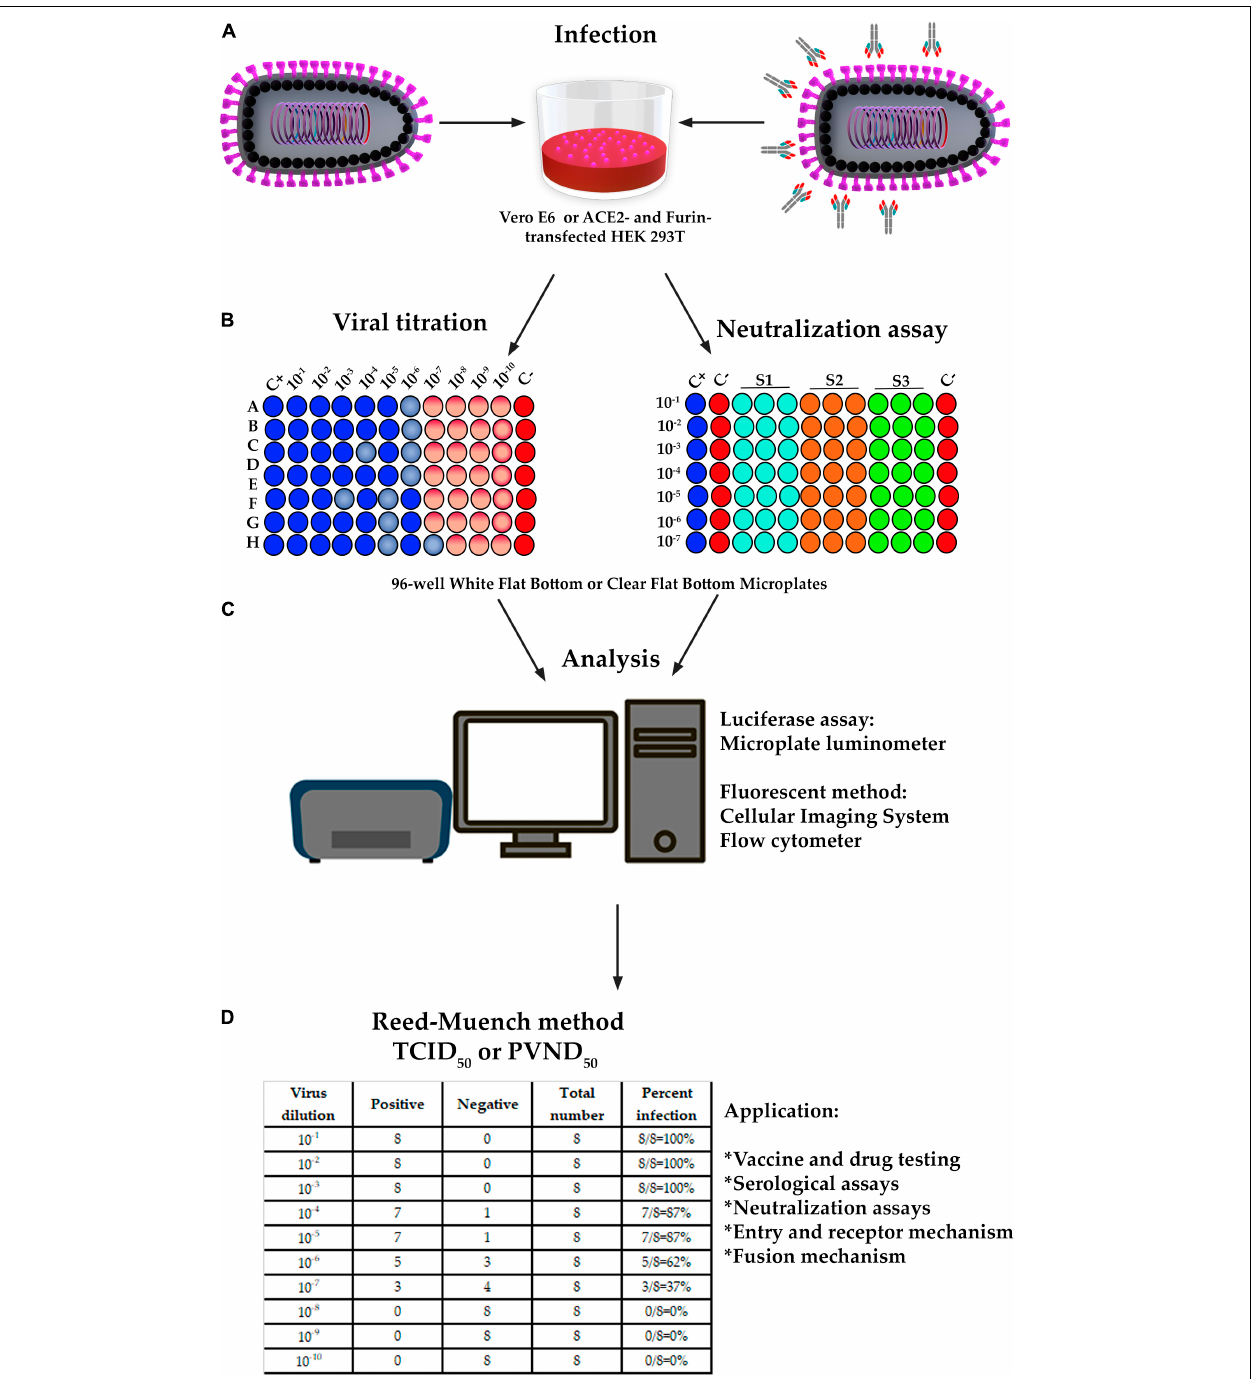
FIGURE 5 | The design of titration and pseudovirus neutralization assay (PVNA). (A,B) Infection, titration and PVNA was performed in a 96-well plate with 10-fold serial dilution of ppVSV (cid:49) G-SARS-CoV-2 S until a total of 8 or 10 dilutions and 6 or 8 replicates were obtained. Neutralization assay was also performed in a 96-well plate with 6 dilutions and 2 replicates; however, the sera samples were previously diluted and then mixed with ppVSV (cid:49) G-SARS-CoV-2 S 325 to 1,300 TCID 50 /mL and incubated for 1 h at 37 ◦ C. (C) In titration, the cells containing the luciferase were lysed to perform the luciferase assay and a 96-well-plate luminometer was used. In the fluorescence method, the DAPI-stained cells containing GFP were analyzed by fluorescence microscope, and the images were analyzed with specialized software. An alternative method is by using a flow cytometer equipped with a 96-well-autosampler. In PVNA, the luciferase activity was determined by the relative light units (RLU) and the fluorescence by the number of GFP-positive cells. Percent neutralization must be normalized considering uninfected cells as 100% neutralization and infected cells with ppVSV (cid:49) G-SARS-CoV-2 S alone as 0% neutralization. (D) The 50% tissue culture infectious dose (TCID 50 ) and/or